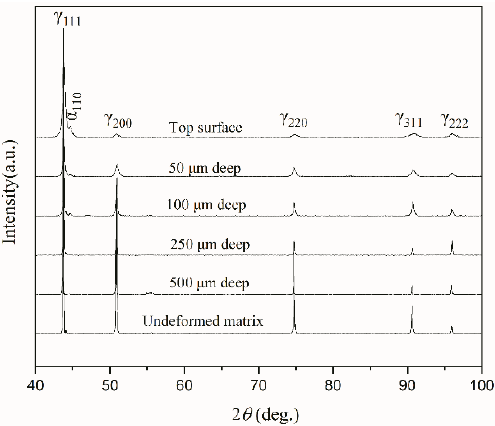
Figure 4. XRD profiles of the AISI 304 stainless steel sample before and after USRT. The profiles for different depths were obtained by removing surface layer of corresponding thickness. γ refers to fcc austenite, while α refers to the bcc martensite.